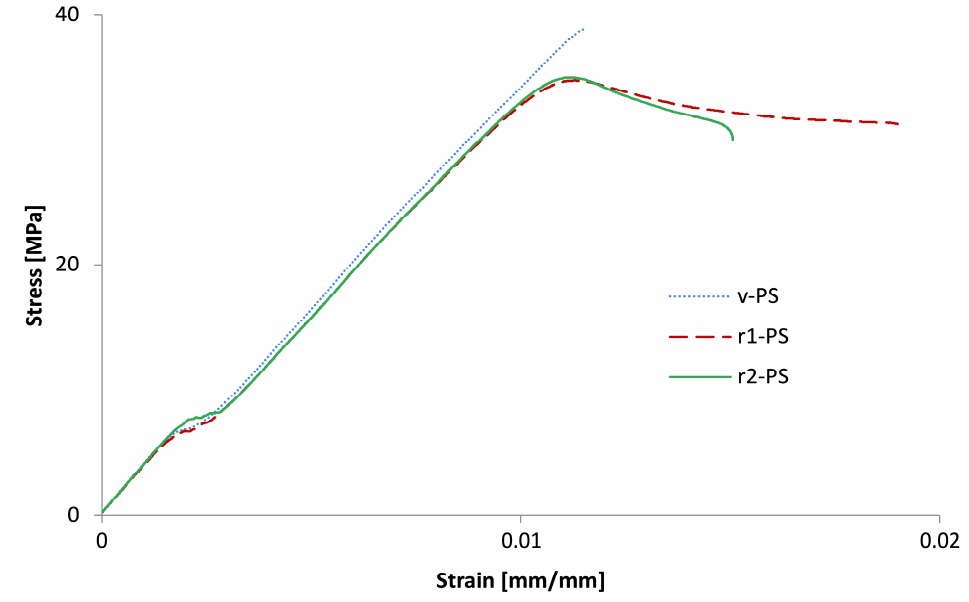
Figure 4. Stress–strain curve of virgin and recycled PS.